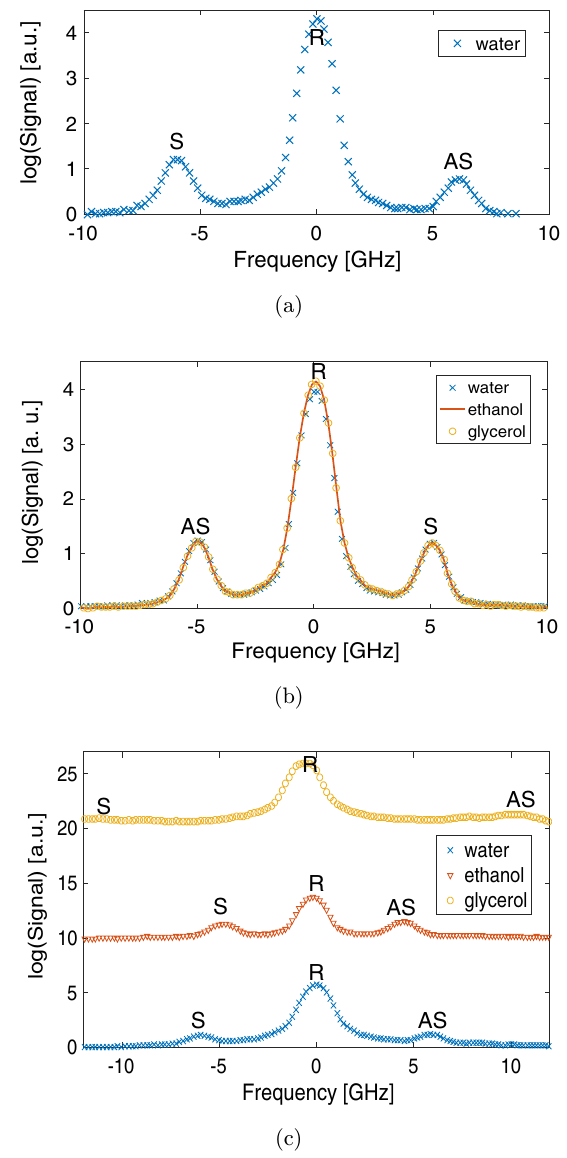
Fig. 3. (Color online) Brillouin spectra acquired using the three optical setups of Figs. 2(a) – 2(c) as per Fig. (2) for water, ethanol and glycerol. The spectra all comprise a central elastic peak (R) and a Brillouin doublet, Stokes (S) and AS peaks, respectively. All three measurements in B are overlapping; hence it is likely that the Brillouin signal originates not from the liquid samples, but from the ¯ber itself. Note that the spectra in C are separated vertically by 10 units for better